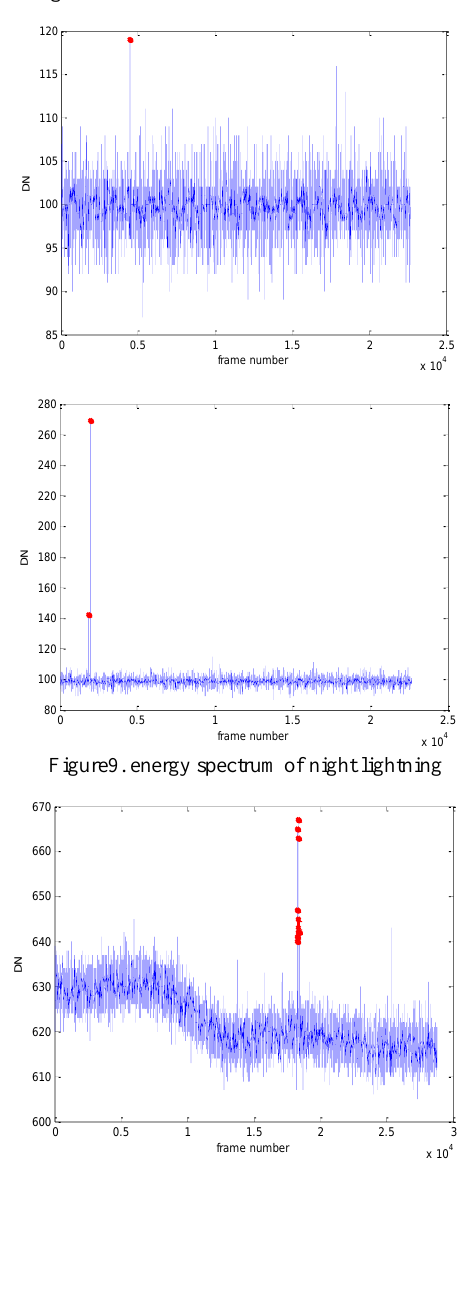
Figure7. Image frame compere